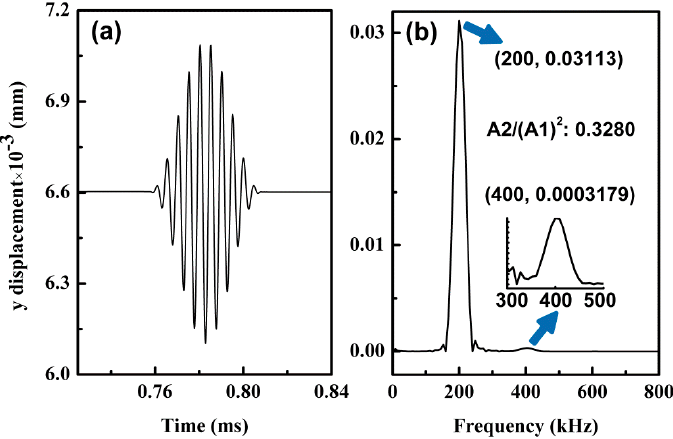
Table 2. Group velocity verification for symmetric (S 0 ) and antisymmetric (A 0 ) mode Lamb waves at center frequencies of 100 kHz and 200 kHz.